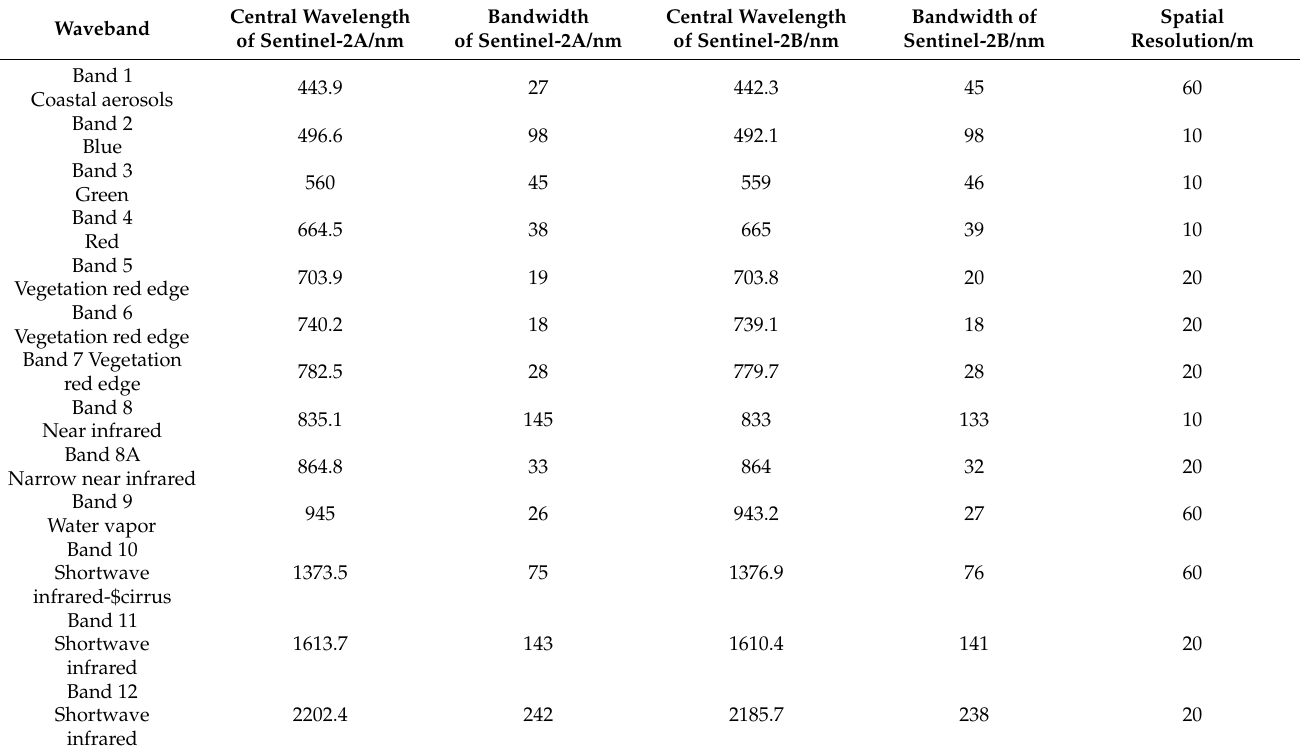
Table 1. Waveband parameters of Sentinel-2.